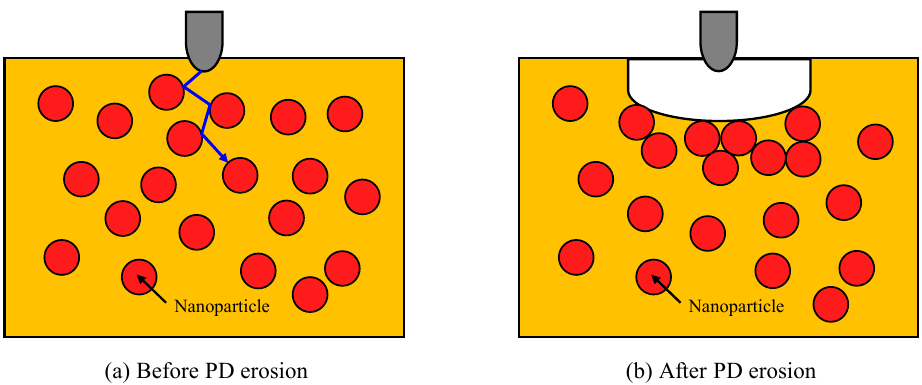
Figure 10. Mechanisms behind reducing PD erosion in polymer nanocomposites; ( a ) before PD erosion and ( b ) after PD erosion.